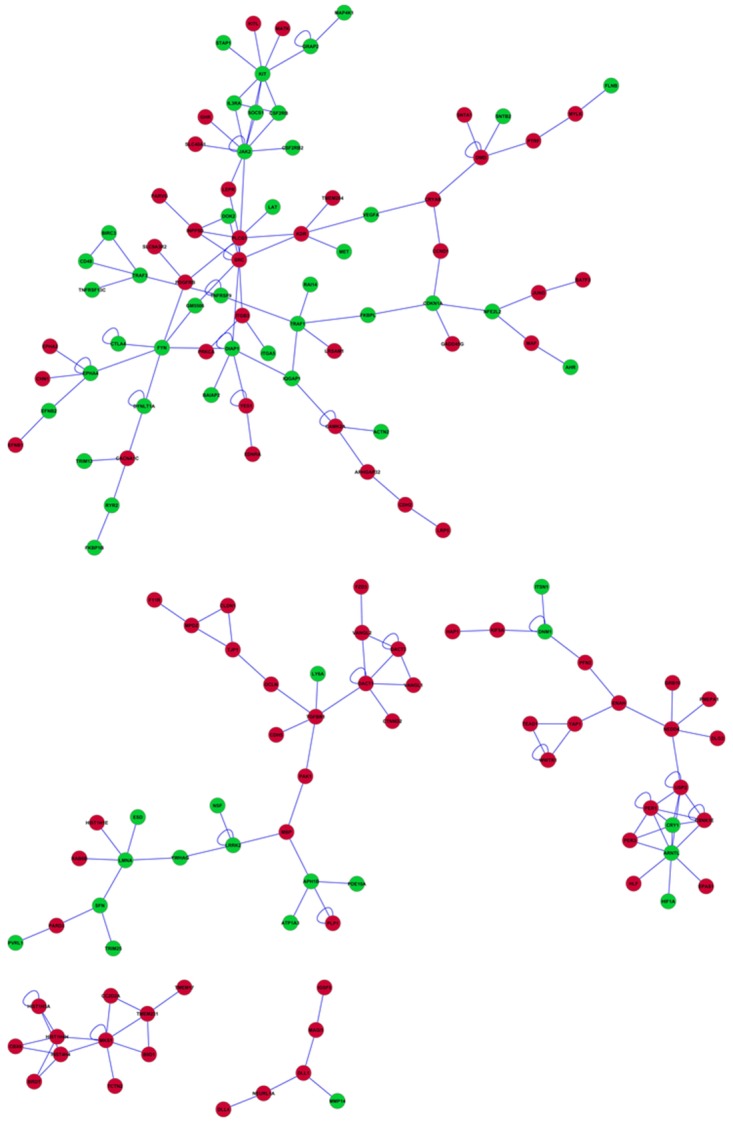
Network of genes differentially expressed between microglia and macrophages in BCG-challenged mice.Red (green) nodes denote genes over- (under-) expressed in BCG-challenged relative to Control mice. All genes were differentially expressed at FDR-adjusted P-value < 0.0001. Edges denote known relationships between genes in the SysBiomics repository. Framed genes (squares) are discussed in the manuscript.